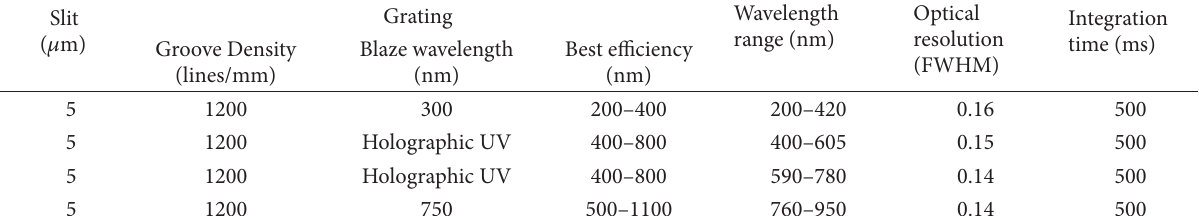
T 2: Optical bench and settings for each